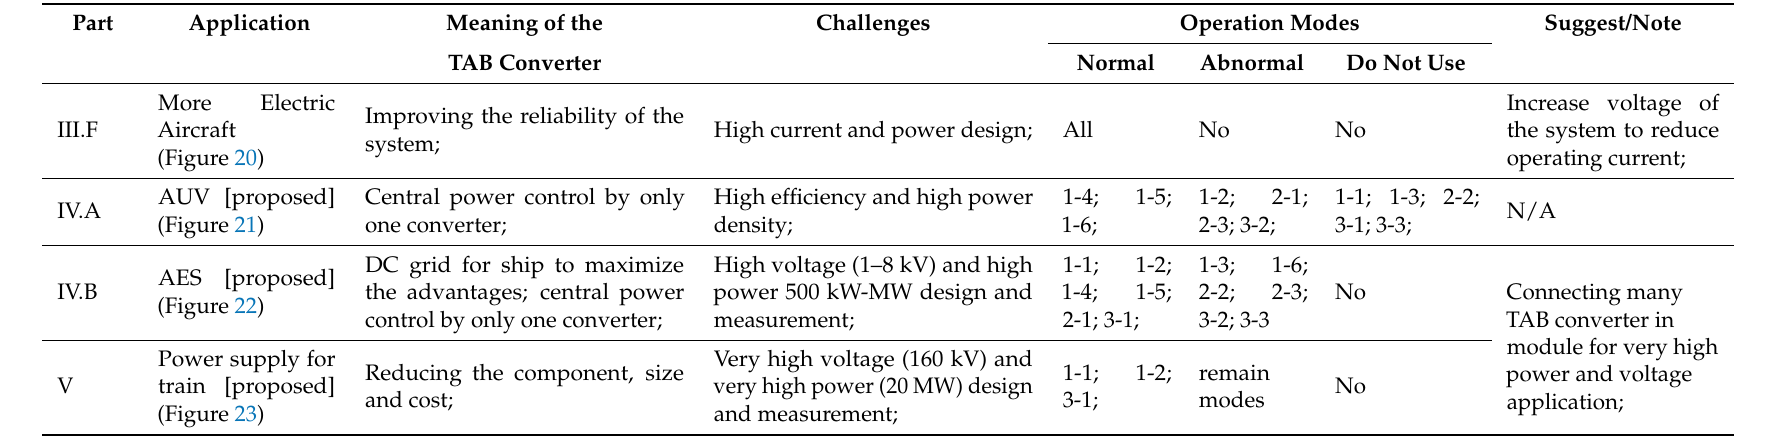
Reducing the component,